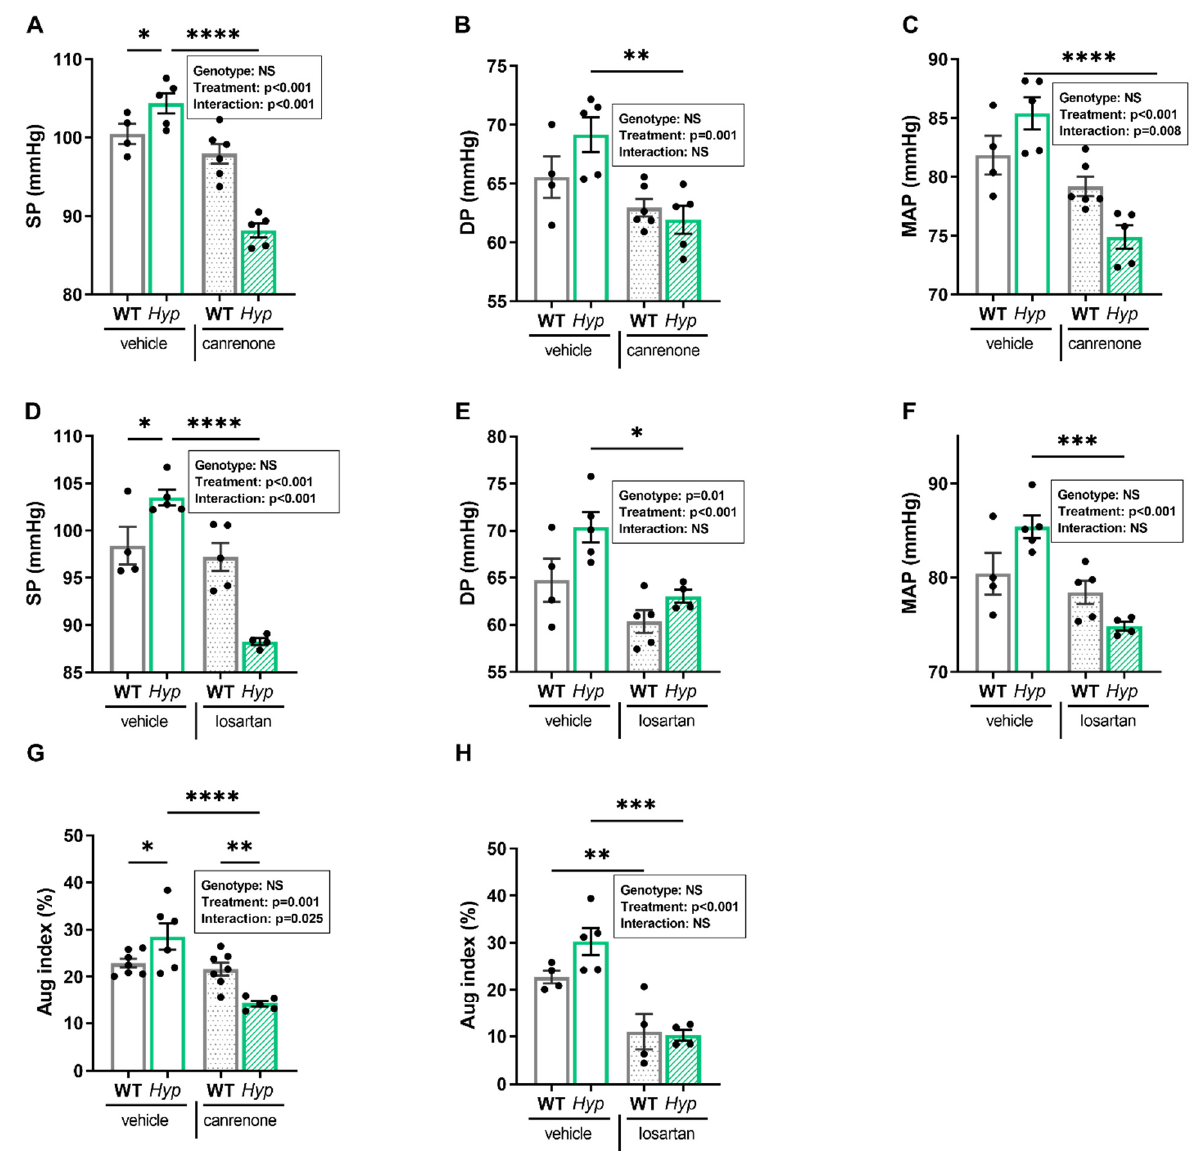
Figure 3. Inhibition of RAAS signaling normalizes blood pressure in Hyp mice. ( A , D ) Systolic (SP), ( B , E ) diastolic (DP), and ( C , F ) mean arterial blood pressure (MAP), as well as ( G , H ) augmentation index (AI) in 12–14-month-old male WT and Hyp mice treated over 5 days with 30 mg/kg canrenone (s.c. once daily) or 30 mg/kg losartan (gavage twice daily) (n = 4–8). Bars represent mean ± SEM. * p < 0.05, ** p < 0.01, *** p < 0.001, **** p < 0.0001 vs. vehicle by one-way ANOVA followed by Student–Newman–Keuls post-hoc test. Insets show results of two-way ANOVA.